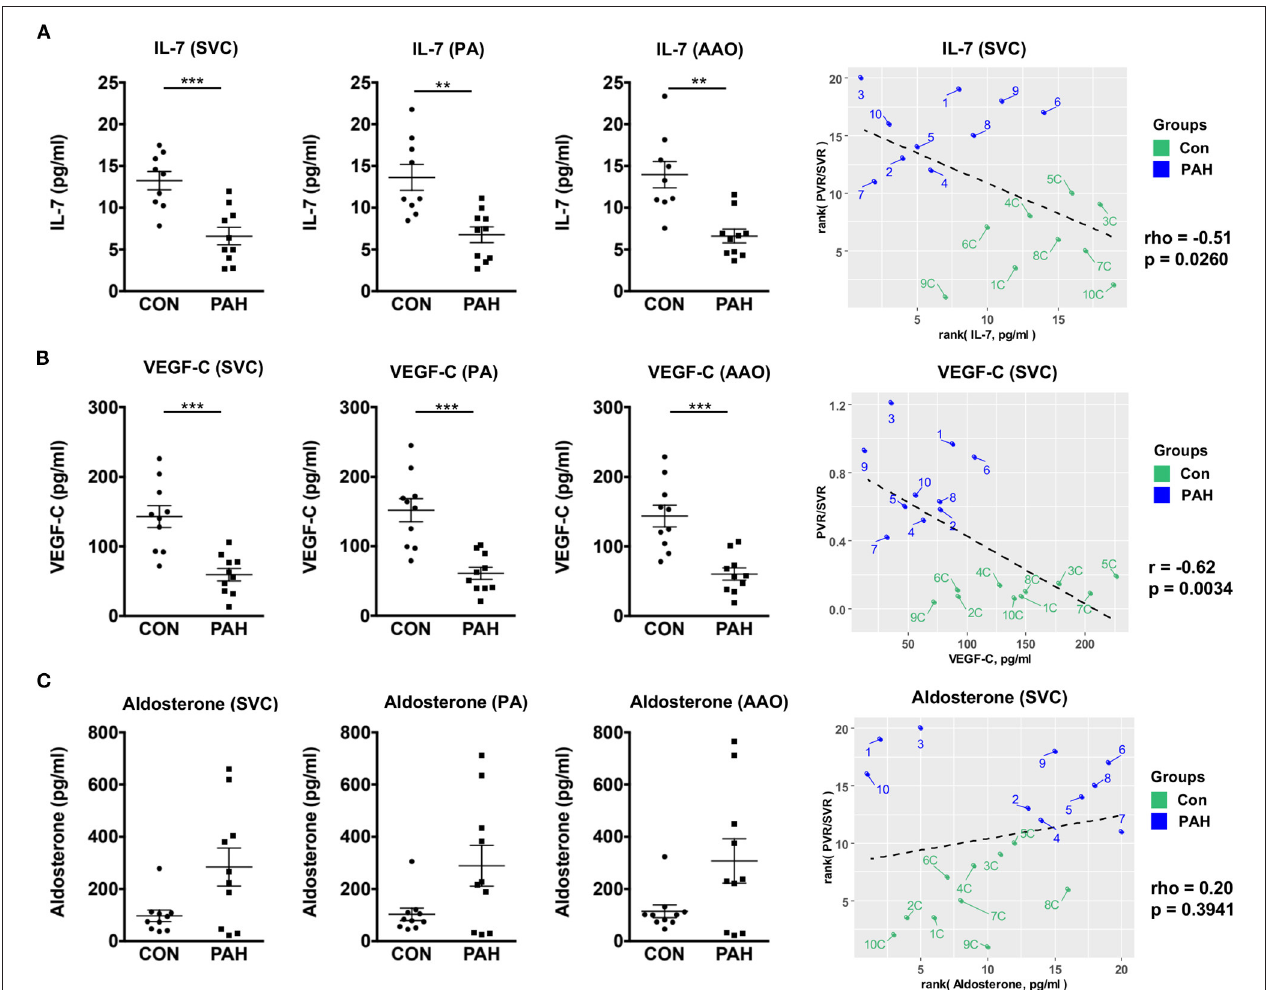
FIGURE 1 | Compartment-specific plasma concentrations of IL-7, VEGF-C and aldosterone in pediatric PH patients vs. non-PH controls. For group comparisons (A–C) mean ± SEM are shown. Statistical test: Unpaired t -test with Welch’s correction or Mann-Whitney U test. ** p < 0.01, *** p < 0.001. (A) Plasma levels of IL-7 were significantly downregulated in PH in all three sites (SVC, PA, and AAO). (B) Plasma levels of VEGF-C were also significantly downregulated in PAH in all three sites. IL-7 (A) and VEGF-C (B) had moderate (negative) correlation with hemodynamic variables (PVR/SVR ratio). (C) No significant differences in plasma aldosterone concentrations were detected, however, the concentrations tended to be higher in PAH in all three sites. Aldosterone only weakly correlated with the measured hemodynamics (PVR/SVR ratio). For correlation analysis, we used either Spearman’s rho (A,C) or Pearson’s r (B) , as appropriate. AAO, ascending aorta; IL-7, interleukin-7; PA, pulmonary artery; PH, pulmonary hypertension; PVR, pulmonary vascular resistance; SVC, superior vena cava; SVR, systemic vascular resistance; VEGF-C, vascular endothelial growth factor